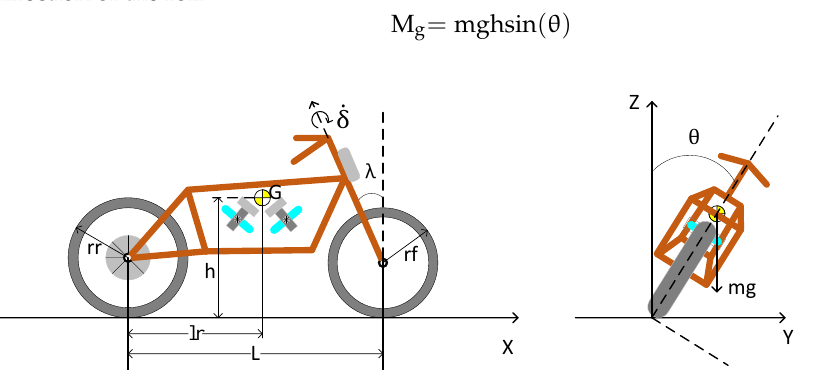
Figure 3. Side view and rear view of the two-wheeled motorcycle equipped with SGCMG.